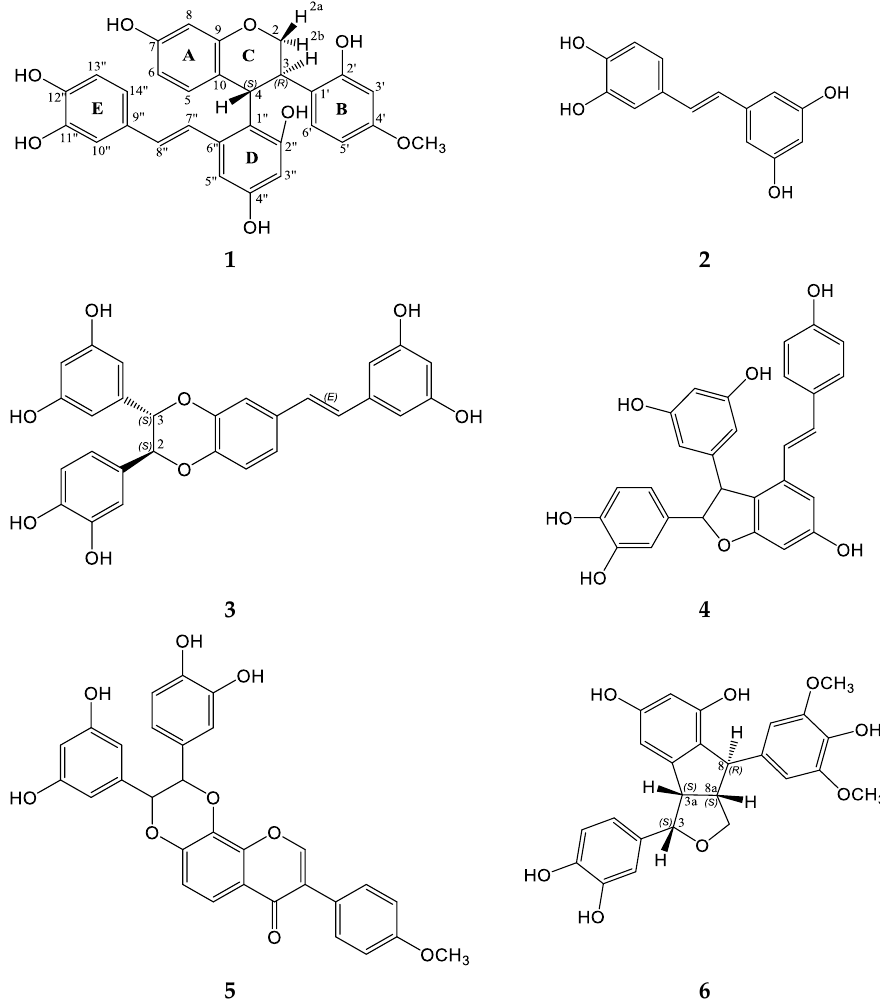
Figure 1. Chemical structures of polyphenolic compounds isolated from M. amurensis heartwood.